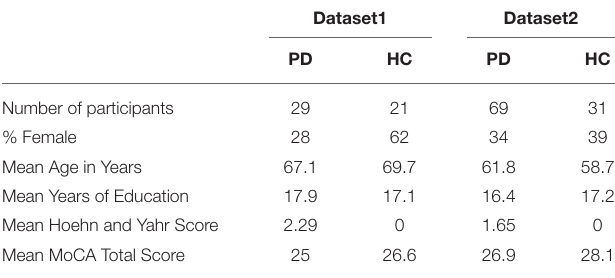
TABLE 1 | Demographic characteristics of study